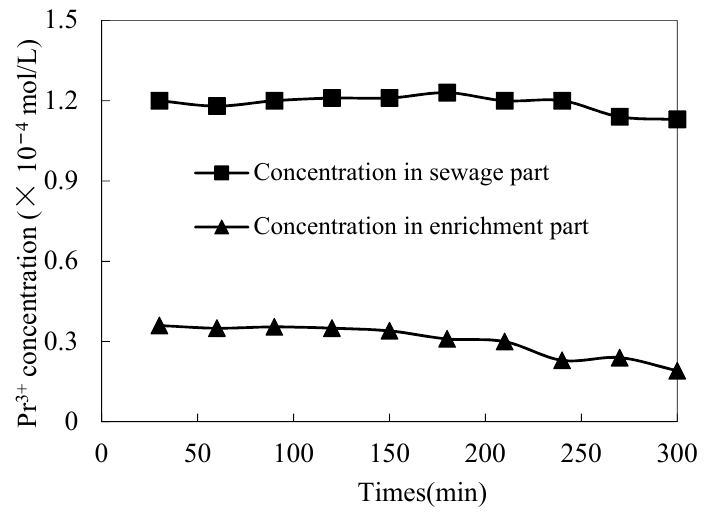
Figure 3. The constancy of MUFR.